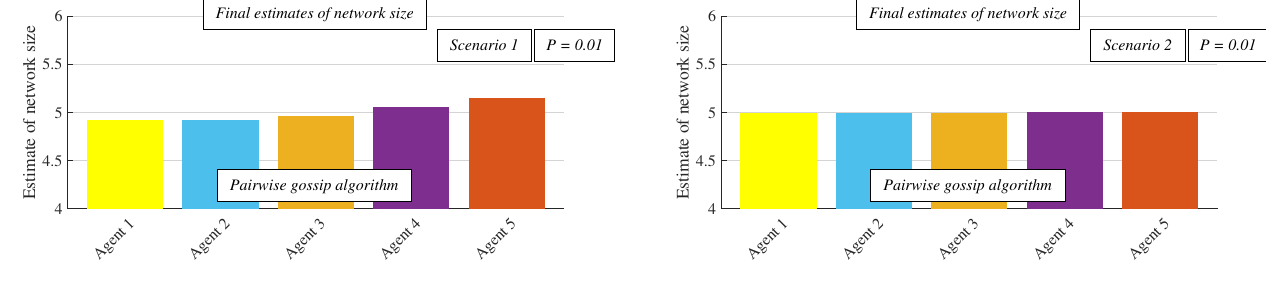
Figure 9. Comparison of final network size estimates in both examined scenarios—pairwise gossip algorithm is